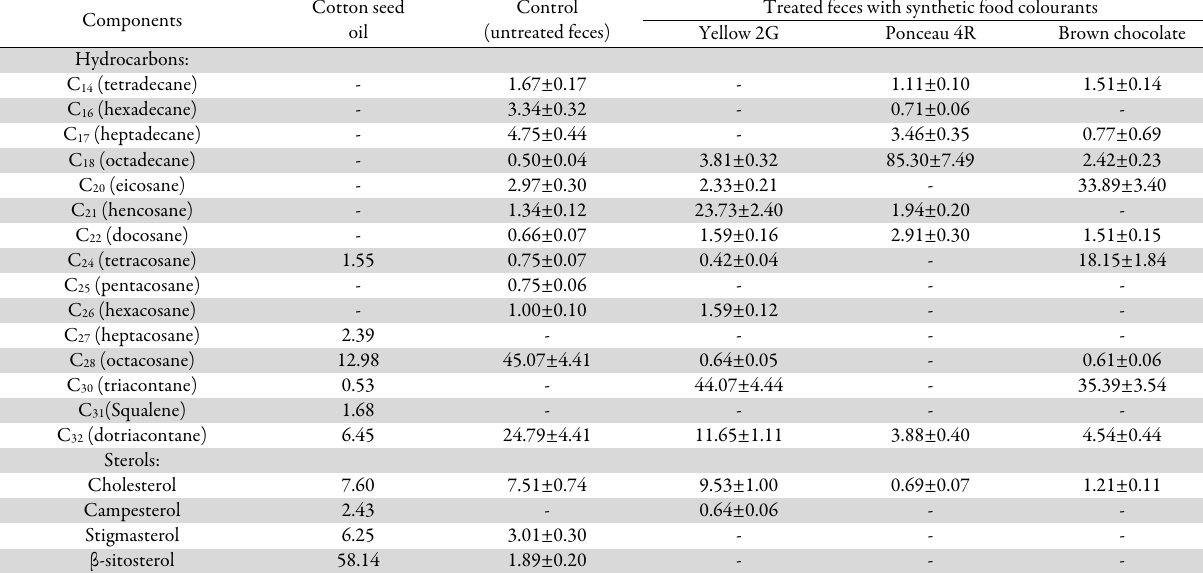
Table 3. Relative percentage of unsaponifiable matters in rat feces affected by synthetic food colourants